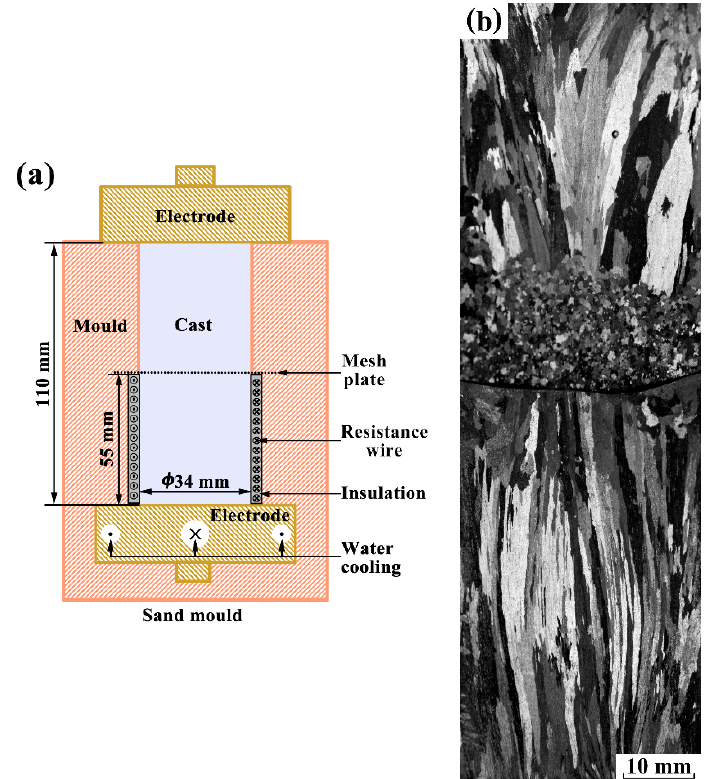
Figure 10. ( a ) Schematic sketch of the improved mold and ( b ) longitudinal sections of the solidification structure in pure aluminum ingots under electropulsing with 900 A with the improved mold.